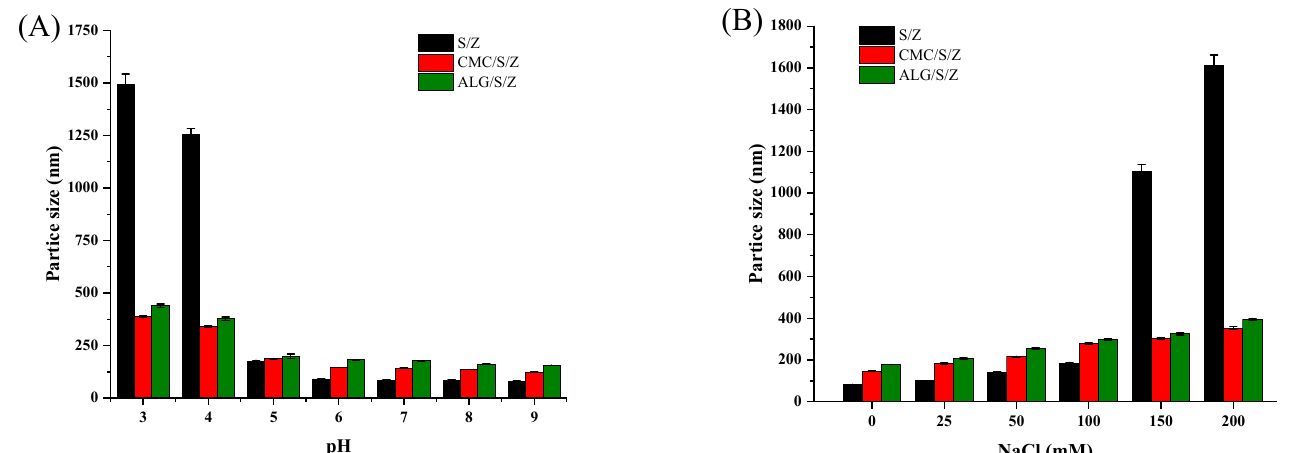
Figure 3. Particle size of colloidal particles at different pH conditions ( A ) and different NaCl concentrations ( B ).